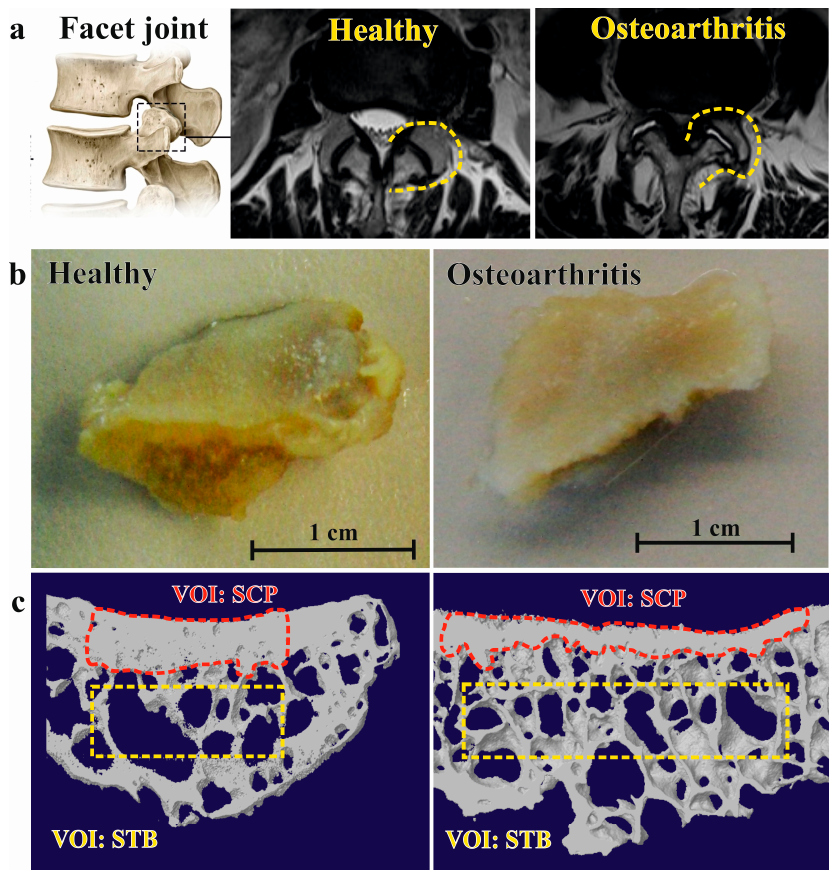
Figure 1. Schematic overview of the study. ( a ) Facet joint anatomy (left) and grading of facet joint osteoarthritis severity on axial MRI images. Healthy joints (Weishaupt grade 0) display no radiological abnormalities or joint space narrowing. Facet joints with severe osteoarthritis (Weishaupt grade 3) display joint effusion (white signal in joint space), joint hypertrophy, and osteophyte formation; ( b ) top view of clinical specimens from healthy (Weishaupt grade 0) and osteoarthritic (Weishaupt grade 3) facet joints obtained by partial facetectomy; ( c ) representative three-dimensional reconstruction images of CT scans indicating selection of volumes of interest (VOI) for analysis of subchondral cortical plate (SCP) and subchondral trabecular bone (STB)